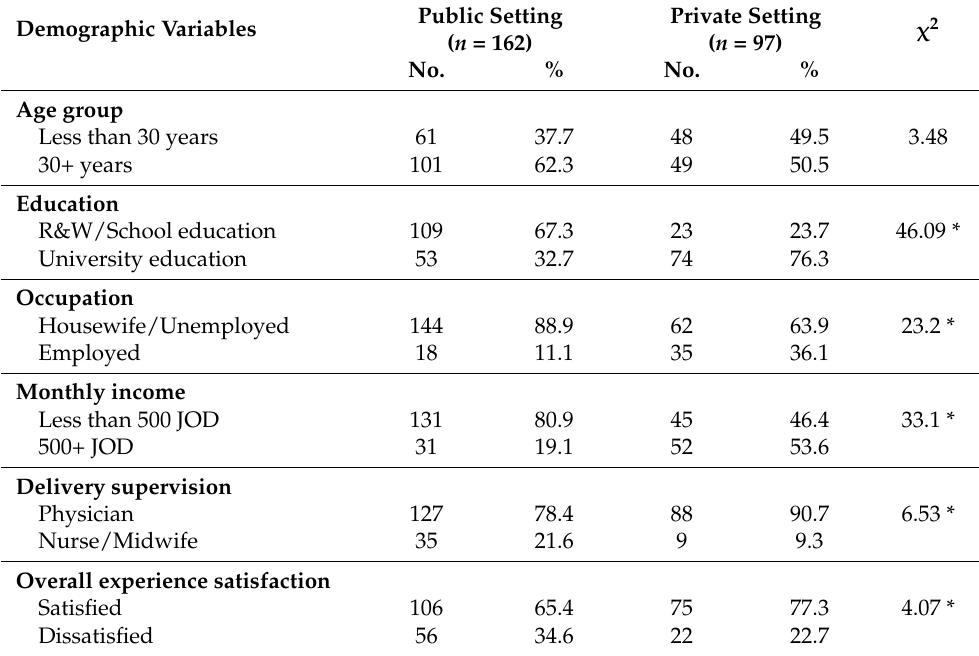
Table 1. Demographic variables at public and private settings of the sample under study (Amman,